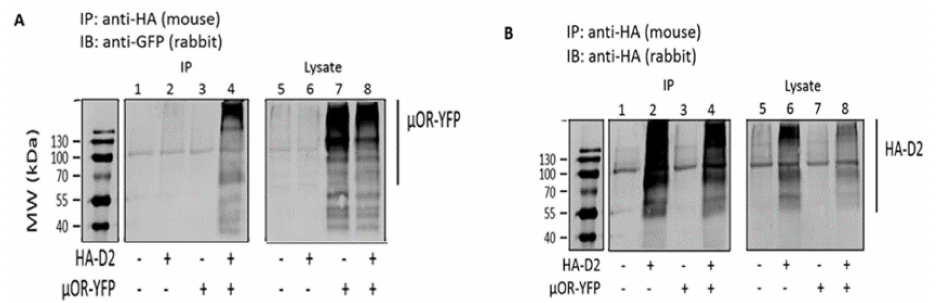
Figure 1. Assessment of D 2 R receptor dimerization with mu opioid receptor (MOR) using coimmunoprecipitation. HEK 293T cells were transiently transfected with pHA-D 2L R,